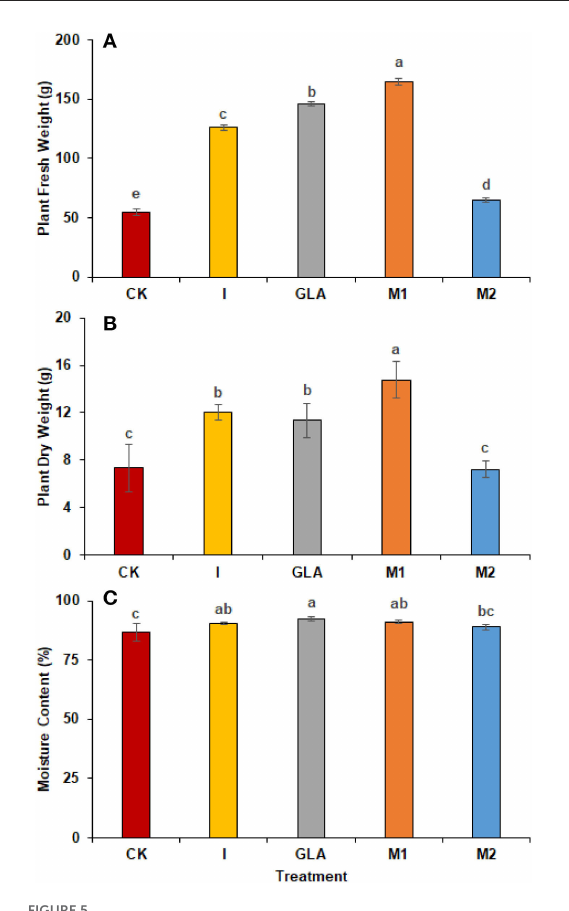
FIGURE5 Plant weight and moisture content: (A) Plant fresh weight, (B) Plant dry weight, (C) Moisture content observed in experiment 2 using chemical fertilizer (CK), Isabion ® (I), glycine + lysine + aspartic acid (GLA), moringa leaf extract + GLA (M1), 25% NPK + M1 (M2). The values mentioned herein are indicated as mean ± S.D and the lowercase letters indicate the significant difference among the